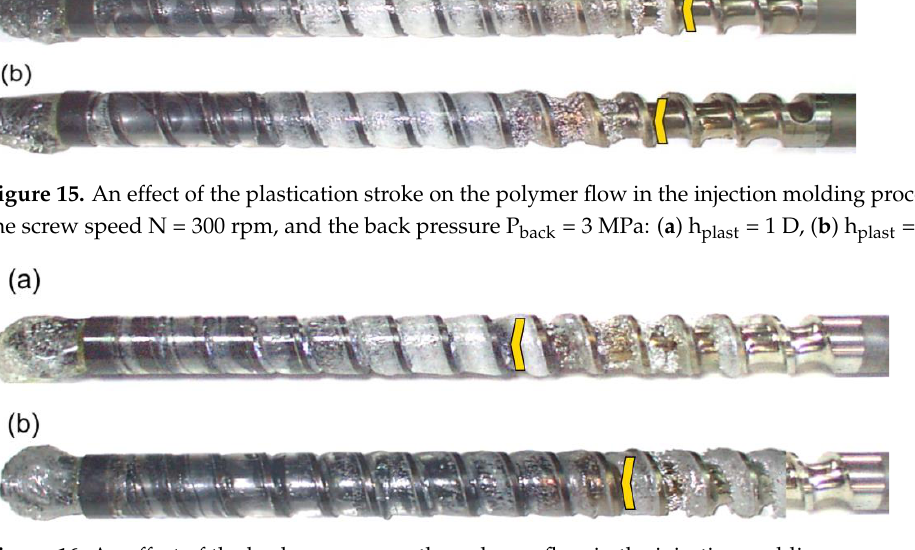
Figure 17. An effect of the back pressure on the polymer flow in the injection molding process at the screw speed N = 100 rpm, and the plasticating stroke h plast = 3 D: ( a ) P back = 0 MPa, ( b ) P back = 2 MPa, ( c ) P back = 3 MPa. Figure 18. An effect of the back pressure on the polymer flow in the injection molding process at the screw speed N = 300 rpm, and the plasticating stroke h plast = 1 D: ( a ) P back = 0 MPa, ( b ) P back = 2 MPa, ( c ) P back = 3 MPa.